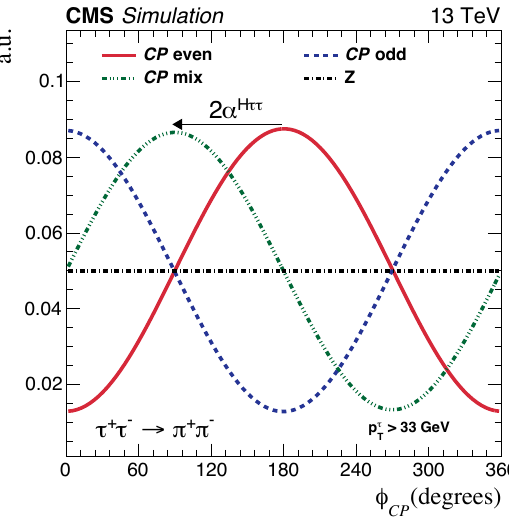
between the t lepton decay planes in the H rest Figure 2 . The normalised distribution of φ CP frame at the generator level, for both t leptons decaying to a charged pion and a neutrino. The distributions are for a decaying scalar ( CP -even, solid red), pseudoscalar ( CP -odd, dash blue), a maximal mixing angle of 45 ◦ ( CP -mix, dash-dot-dot green), and a Z vector boson (black dash-dot). The transverse momentum of the visible t decay products p t was required to be larger than 33 GeV T during the event